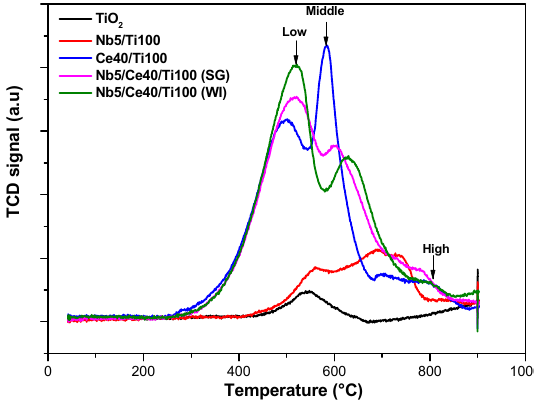
Figure 9. H 2 -TPR profiles of the fresh samples.